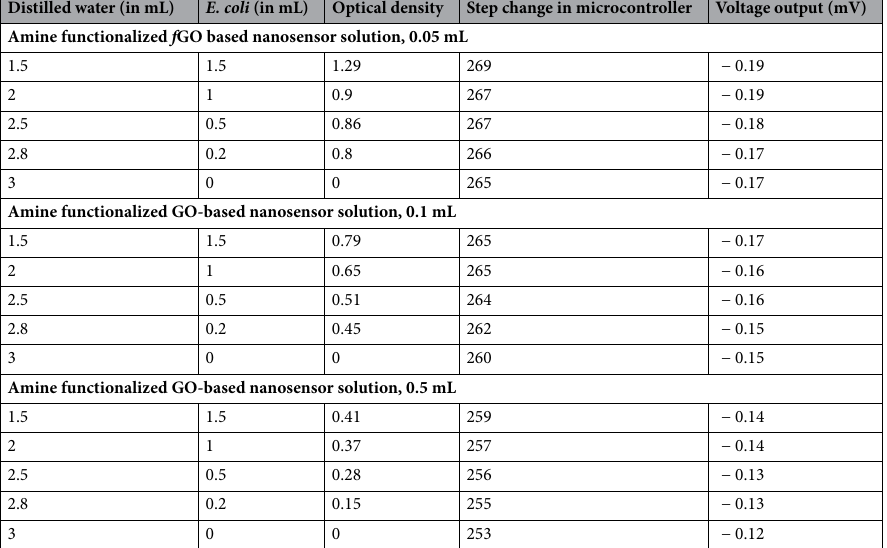
Table 2. Experimental data for varying molar weight of antigen and antibody